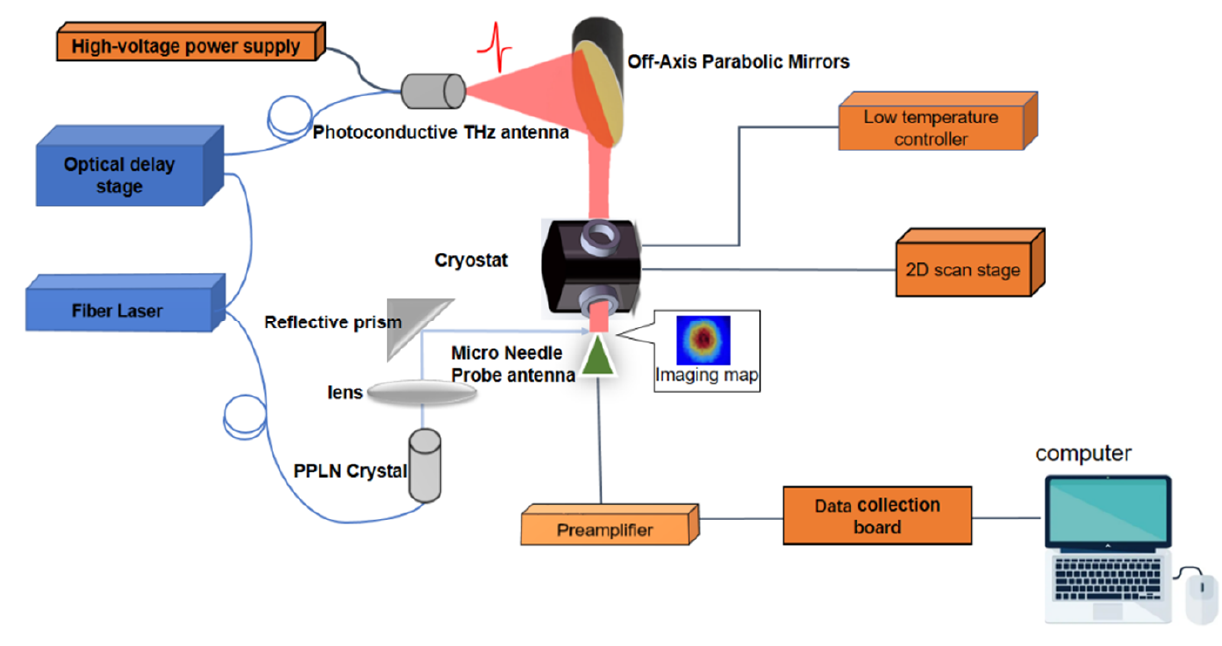
Figure 1. The schematic of Microprobe THz time-domain spectroscopy.